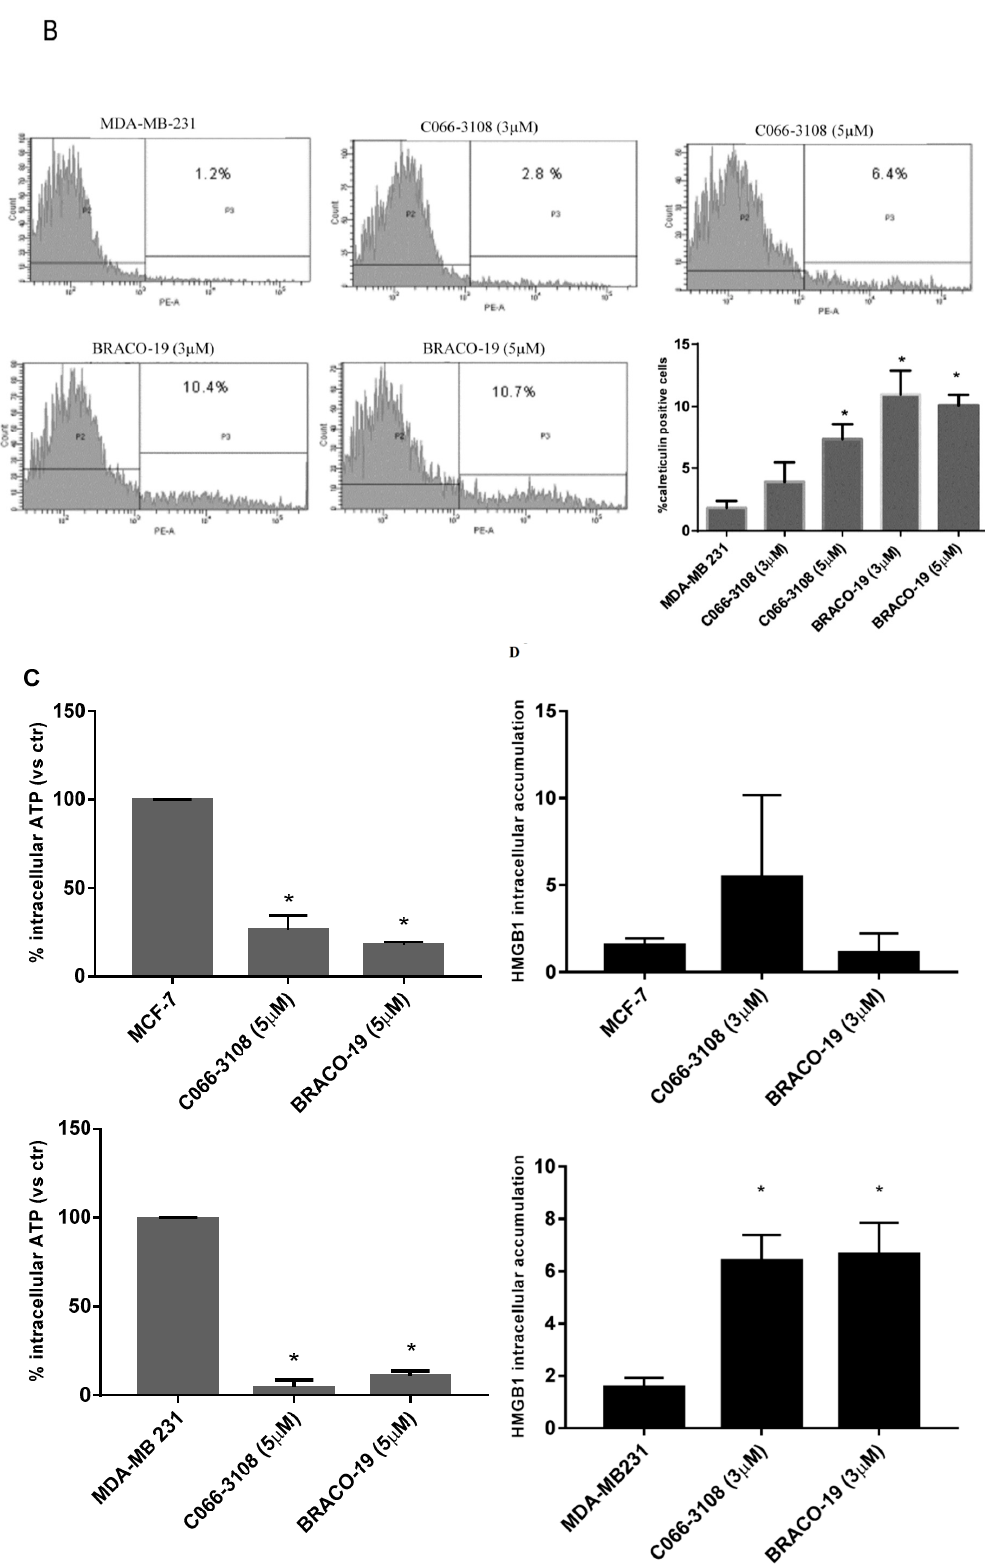
Figure 5. ICD induction by G4 ligands. ICD hallmarks were evaluated in MCF-7 and MDA-MB 231 cells treated with G4 ligands. Calreticulin expression as cell surface marker was evaluated in MCF7 ( A ) and MDA-MB231 ( B ) cells. Representative flow cytometry profiles of a single experiment are reported, whereas the histograms represent the mean ± SD of three independent experiments (* p < 0.005). ATP intracellular release by MCF-7 and MDA-MB231 treated with G4 ligands at 5 µ M was determined as luminescence by microwell plate reader ( C ) the histograms represent the mean ± SD of